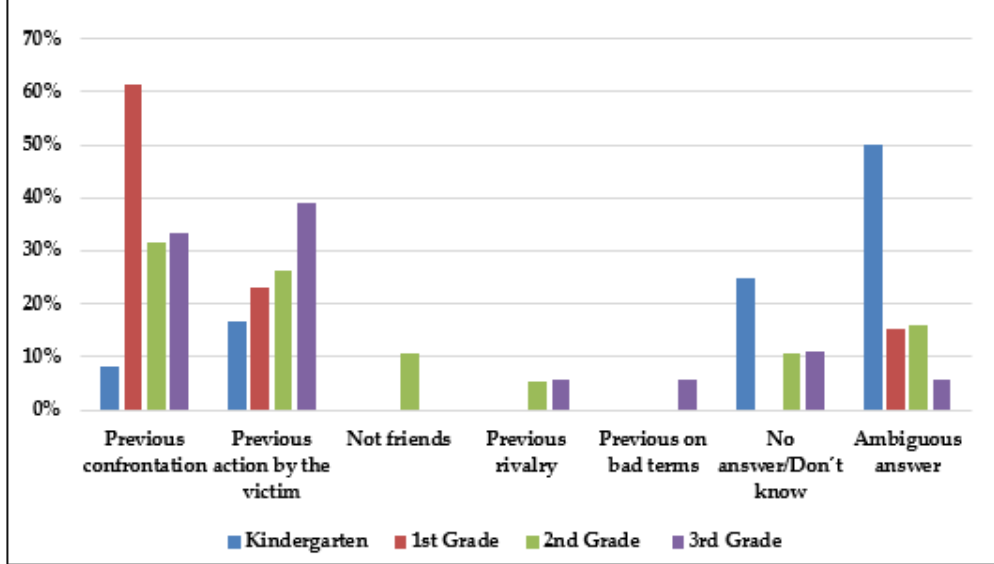
Figure 5. Existence of antecedents per grade.